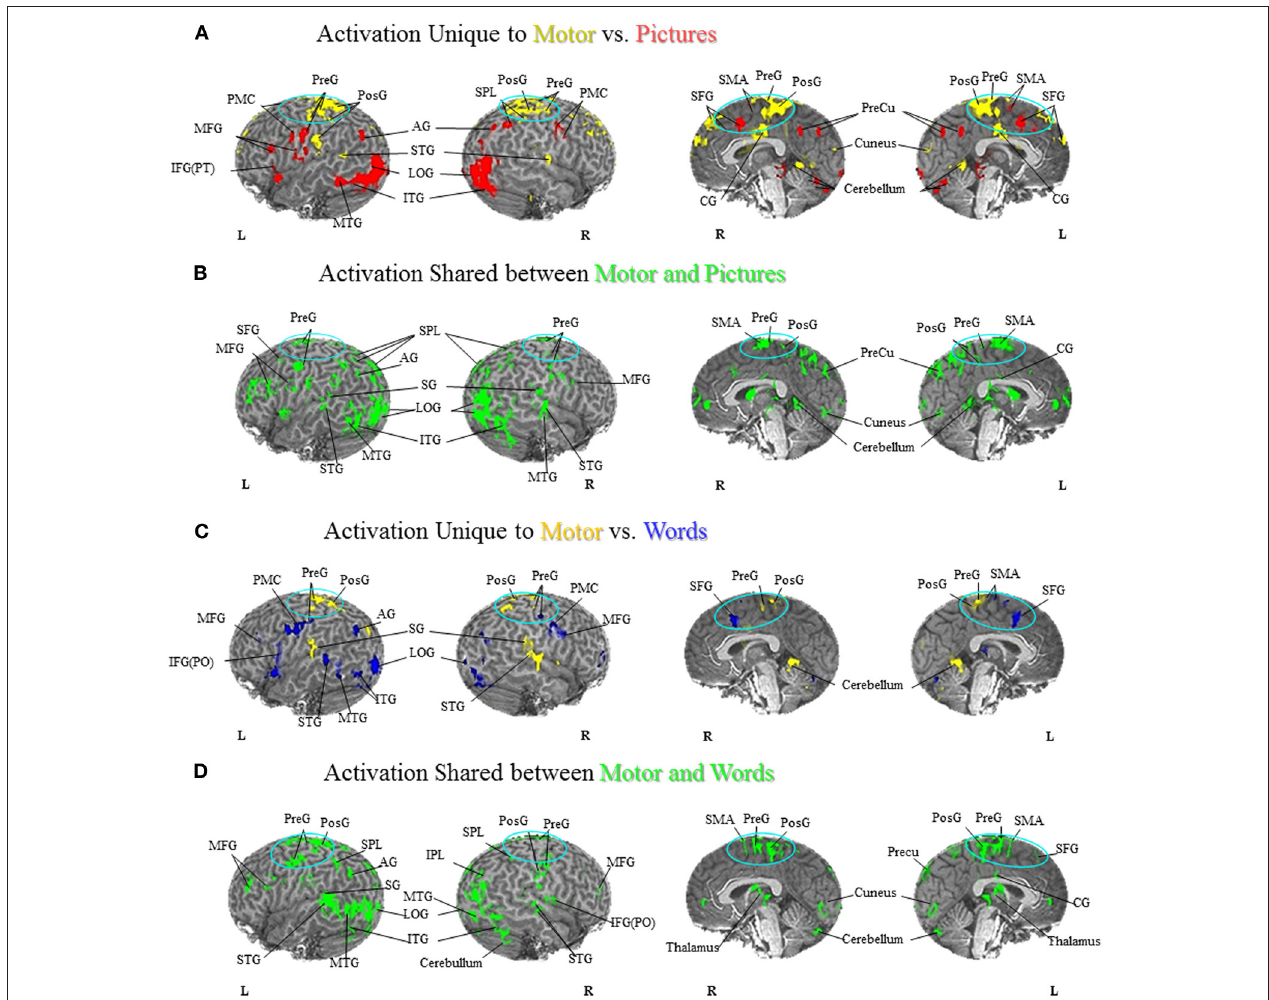
FIGURE 1 | Foot Motor Localization versus Semantic Generation. (A) Activation Unique to Motor vs. Pictures. Activation unique to the motor localization task (yellow coded activation) was found in bilateral superior temporal gyrus (STG), precentral gyrus (PreG) and postcentral gyrus (PosG), and the right superior parietal lobule (SPL) on the lateral surface. Activation was also found in bilateral PreG, PosG, supplementary motor area (SMA), superior frontal gyrus (SFG), and cingulate gyrus (CG) along the midline. For the semantic generation to foot picture stimuli (red coded activation), activation was found in bilateral premotor cortex (PMC) and angular gyrus (AG) on the lateral surface. Activation was also found in the left PreG, middle frontal gyrus (MFG), inferior frontal gyrus [pars triangularis; IFG(PT)], as well as the right SPL on the lateral surface. Activation along the midline was found in bilateral, SMA, SFG, and precuneus (PreCu). Regions of unique activation for the semantic generation to foot picture stimuli and motor localization task outside the PFN were found in bilateral inferior temporal gyrus (ITG) and lateral occipital gyrus (LOG), as well as the left middle temporal gyrus (MTG) on the lateral surface. Activation along the midline was found in bilateral cuneus and cerebellum. (B) Activation Shared between Motor and Pictures. Activation shared between the motor localization and semantic generation to foot picture stimuli (green coded activation) was found in bilateral PreG, SPL, and MFG, as well as the left SFG, supramarginal gyrus (SG), and AG on the lateral surface. Activation was also found in bilateral SMA, PreG, PosG, PreCu and CG along the midline. Regions of activation shared between the motor localization and the semantic generation to foot picture stimuli outside the